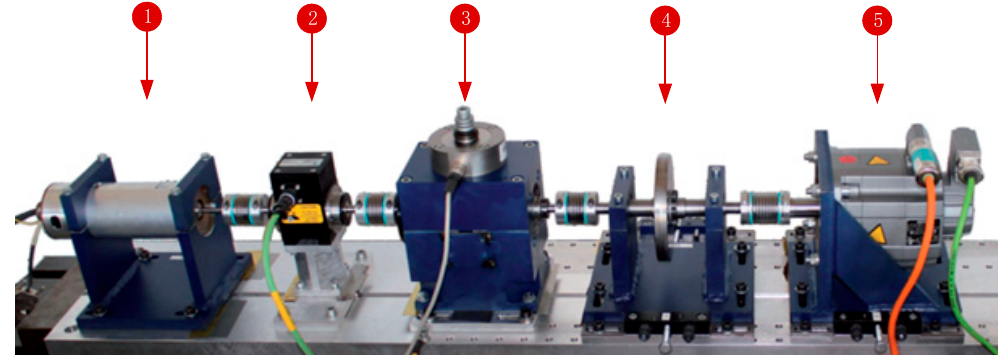
Figure 5. Mechanical setup of the test rig: (1) test motor; (2) measuring shaft; (3) bearing module; (4) flywheel; (5) load motor.